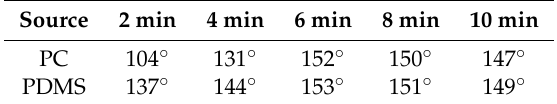
Table 1. Contact Angle Measurement for the Crystallized PC Surface and the Copied PMDS Surface.